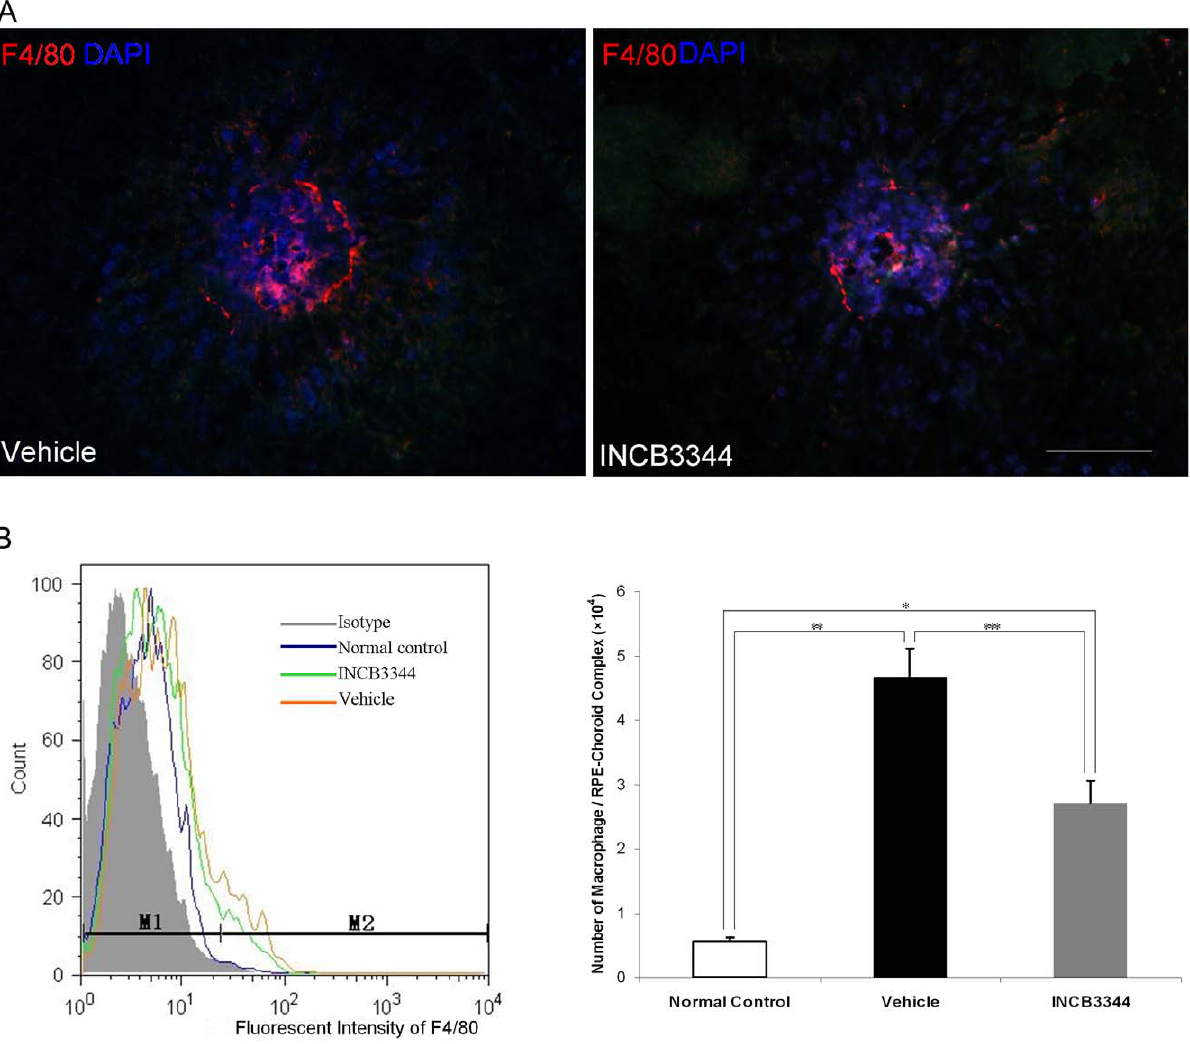
Figure 2. Macrophages detected by immunohistochemistry of choroid-RPE flat mounts and flow cytometry. ( A ) Immunohistochem- istry of macrophages in choroid-RPE flat mounts on Day 3. After photocoagulation, a large number of macrophages accumulated at the laser injury sites. INCB3344 suppressed this increase. Scale bar=100 m m. ( B ) Left: Overlay histogram of flow cytometric results. Right: Flow cytometric analysis data with F4/80 staining of the macrophages in choroid-RPE on Day 3 after laser photocoagulation (Macrophage numbers per choroid-RPE complex). After photocoagulation, the number of macrophages significantly increased compared with no laser photocoagulation controls (relative to normal control, * P , 0.001 n =5, ** P , 0.001 n =5). INCB3344 treatment significantly reduced the number of macrophages compared to the vehicle-treated group ( *** P , 0.001, n =5).